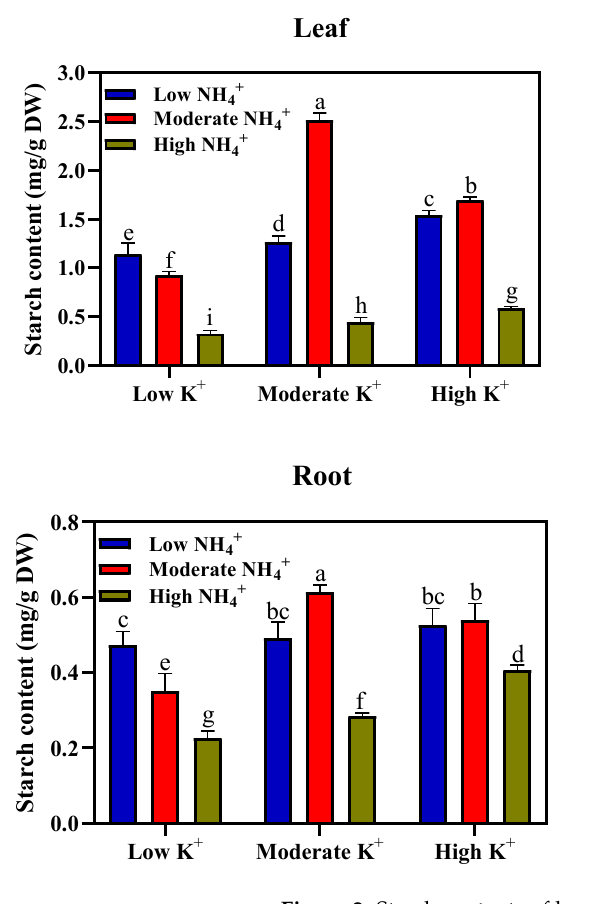
Figure 2. Starch contents of leaves, stems, and roots (mg/g DW) of tobacco seedlings under different NH 4+ and K + levels. Different letters indicate significant differences between means ± SD at the p < 0.05 level ( n = 9) .